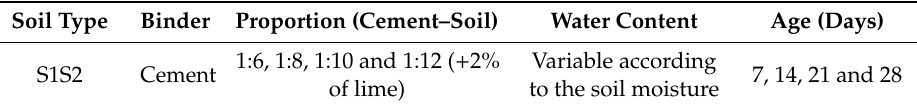
Table 1. Components of CEBs.